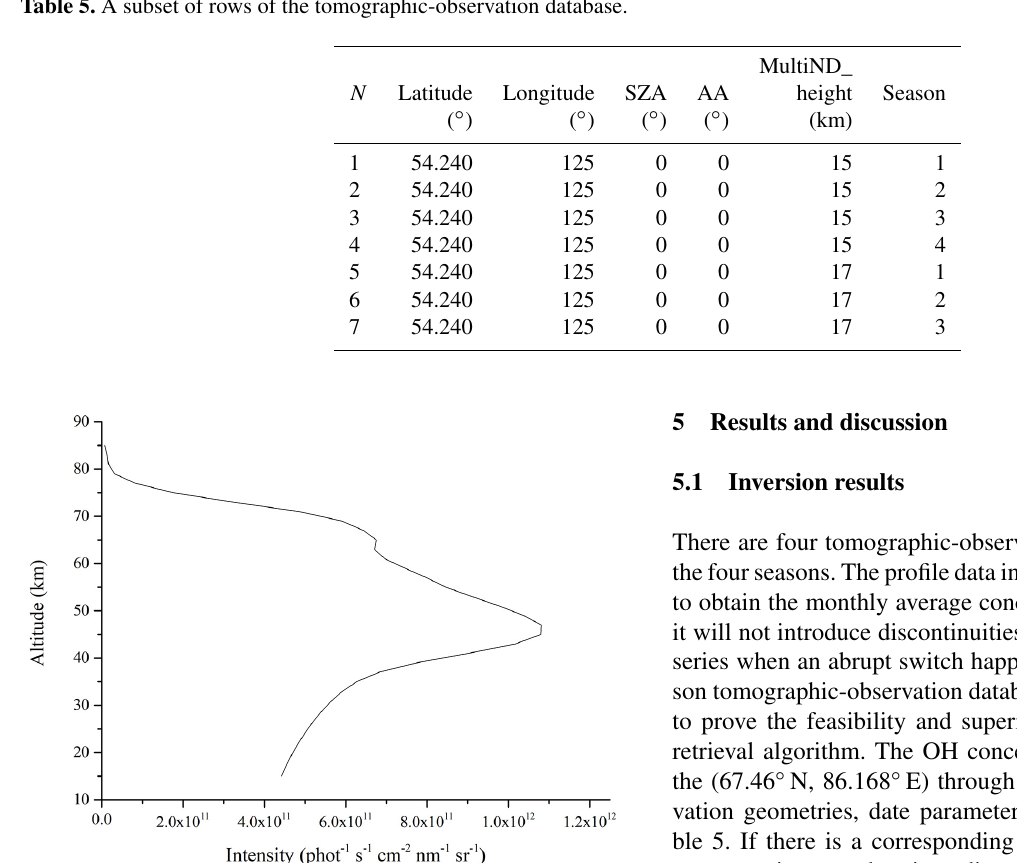
Table 5. A subset of rows of the tomographic-observation database.